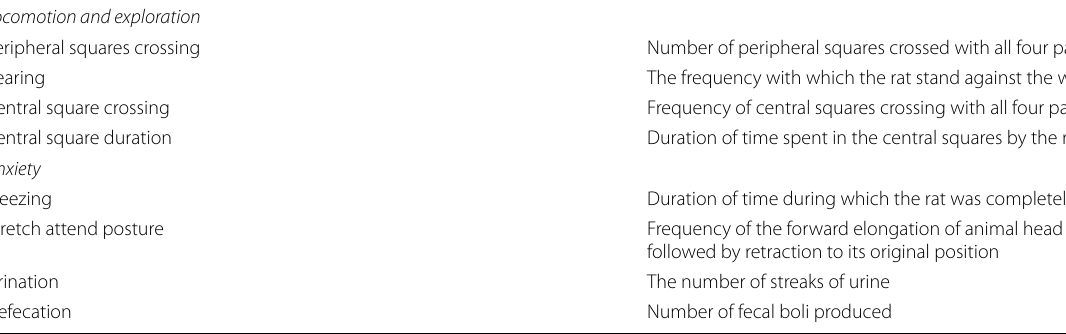
Table 1 Open field test scoring parameters Locomotion and exploration Peripheral squares crossing Number of peripheral squares crossed with all four paws of rat